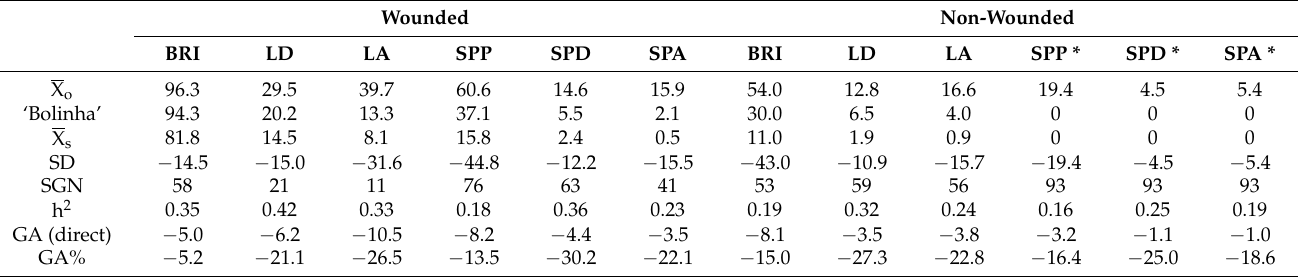
Table 3. Genetic advancement by selection of genotypes better than or equal to ‘Bolinha’. Wounded Non-Wounded BRI LD LA